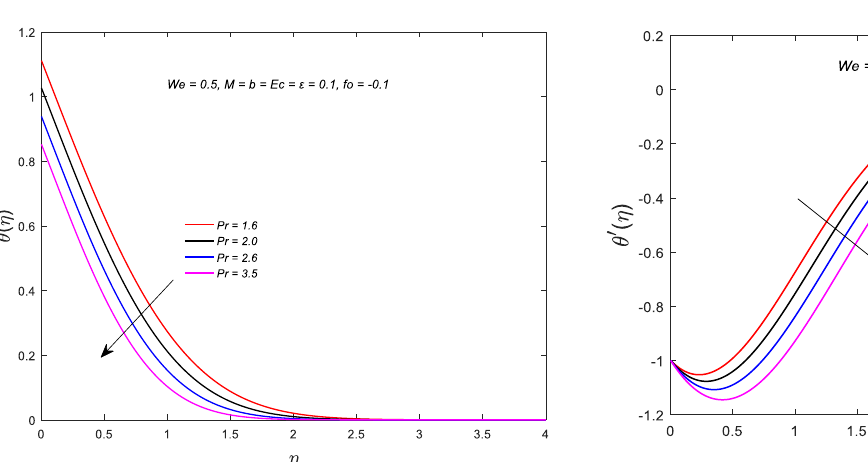
Figure 13: Effect of b on θ (cid:48) ( η )